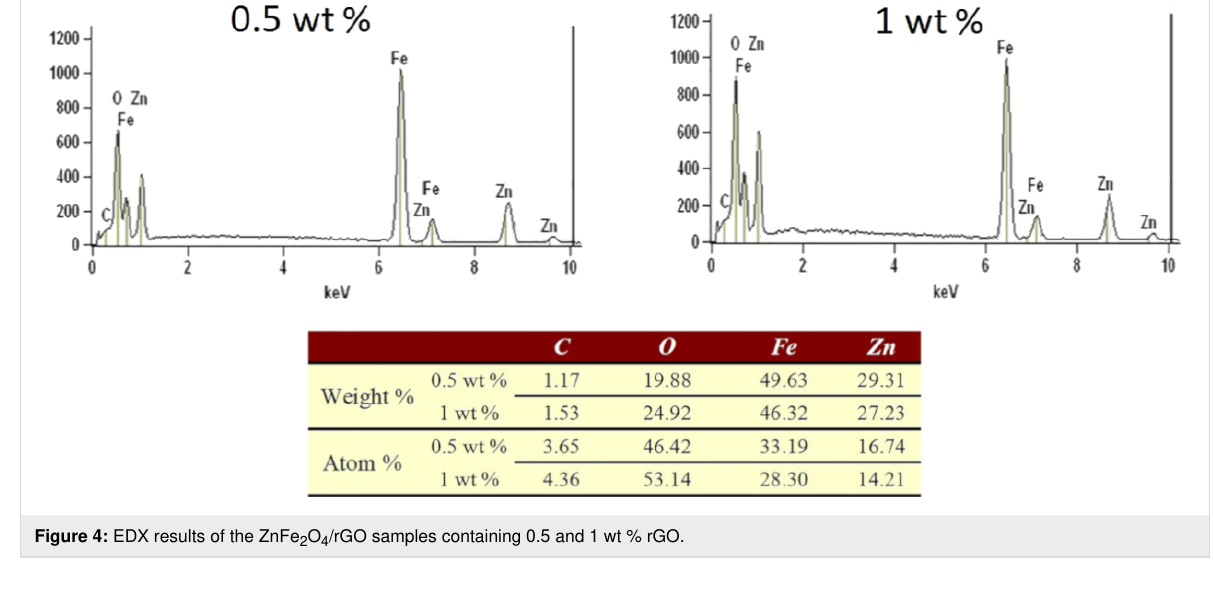
0.5 wt % ZnFe 2 O 4 /rGO gas sensor showed a better